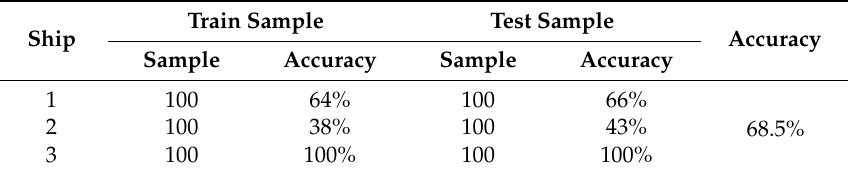
Table 8. The center frequency classification results without denoising.